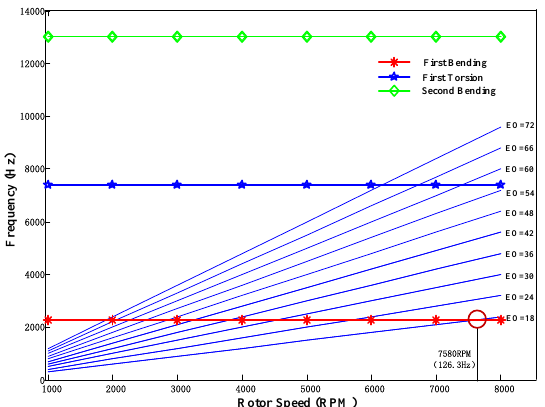
Figure 13. Campbell diagram of experimental setting blade first three modes with 18 EO crossing at 2278 Hz and 7580 rpm. Sensors 2017 , 17 , 1745